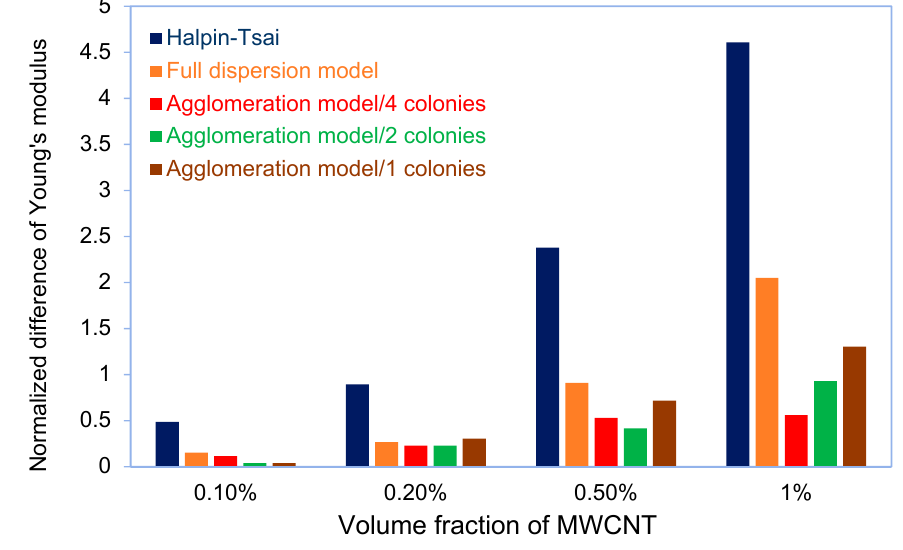
00.511.522.533.544.55 Figure 17. Comparison of the normalized difference of Young’s modulus from FEA modeling and Halpin–Tsai equation relative to the experimental results. Figure 18. Effect of CNTs agglomeration on Young’s modulus of CNT/epoxy nanocomposite for four colonies model and 1 Vf.% CNT loading.